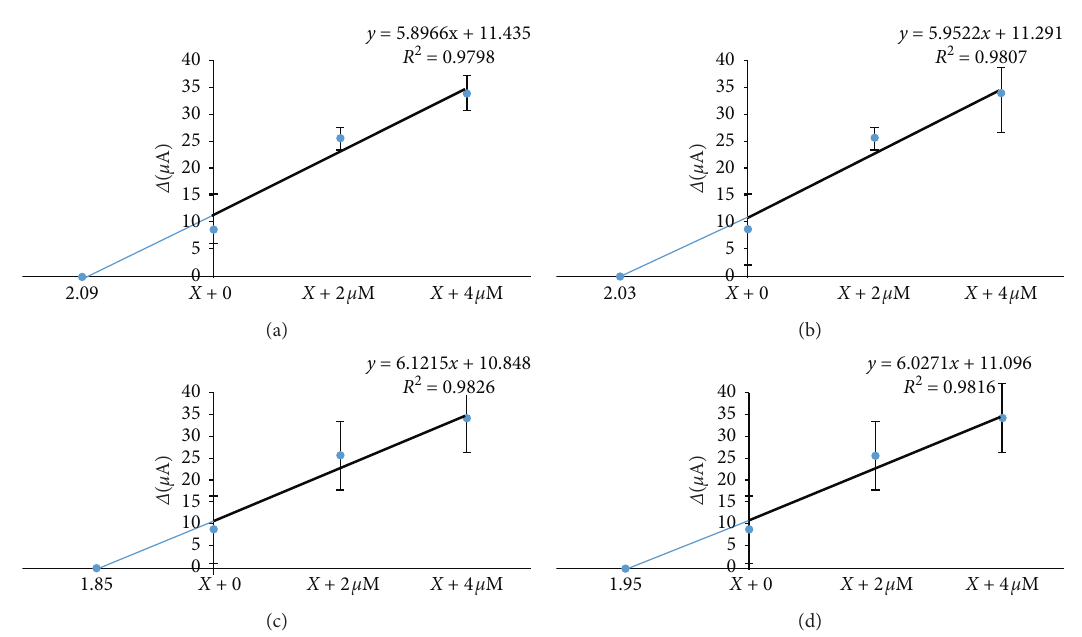
Figure 5: The calibration curve for (a) milk, (b) yoghurt, (c) cheese, and (d) dough. Table 5: The results of MEL determination in food sample analysis. Sample